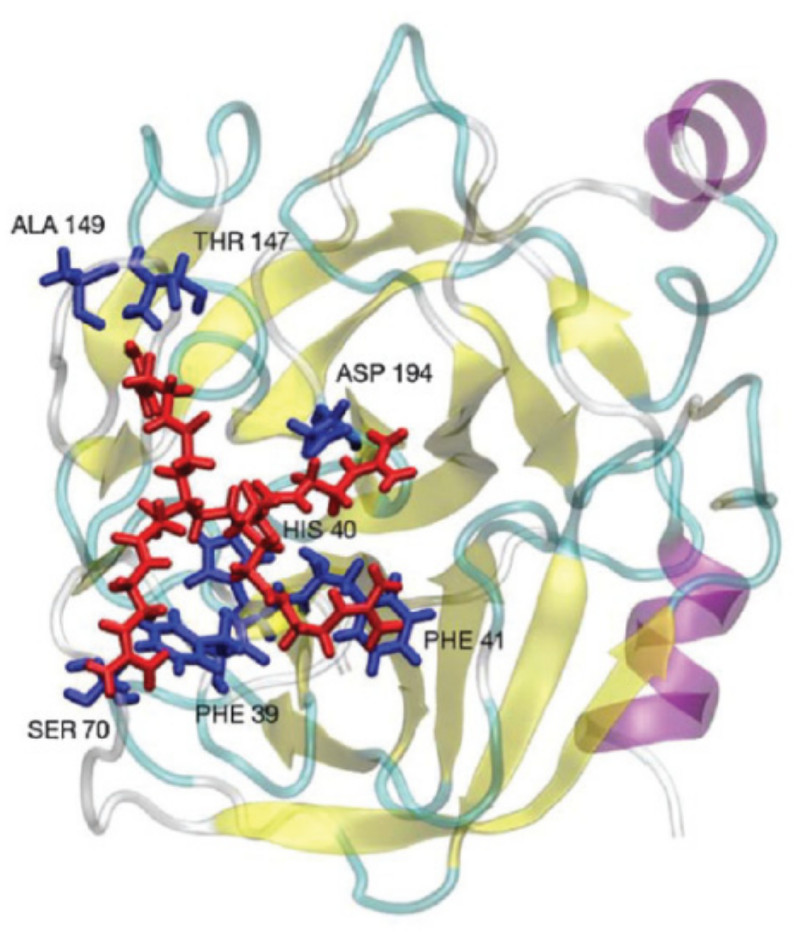
Figure 2. The structure of the complex between PAMAM dendrimers modified with guanidine moieties and alpha-chymotrypsinogen A obtained by molecular dynamic simulations. PAMAM dendrimer with guanidinium chloride surface interacting with multiple groups on the surface of protein. Reprinted with permission from [108]. Copyright 2011, Public Library of